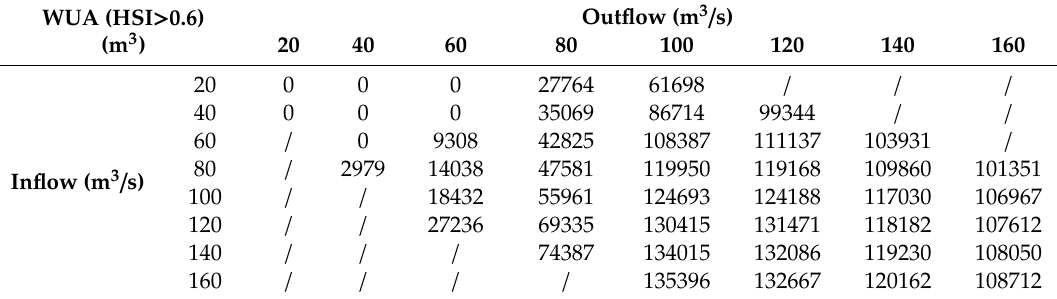
Table 4. WUA (HSI > 0.6) under di ff erent inflow and outflow scenarios.